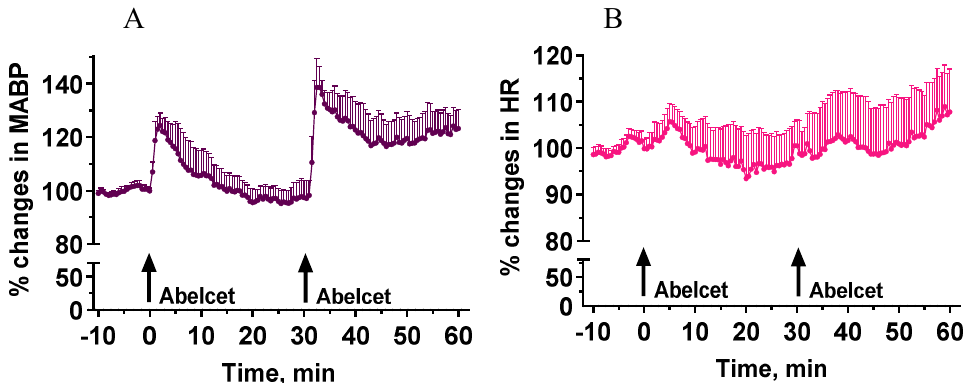
Figure 1. Effects of two sequential treatments with Abelcet (30 mg/kg, i.v.) on MABP and HR in anesthetized NMRI mice (n = 5). The time of i.v. Abelcet injection is indicated by arrows. ( A ): mean arterial blood pressure (MABP); ( B ): heart rate (HR). The two MABP and HR curves (for 30 min from Abelcet administration) were compared using two-way ANOVA for repeated measurements followed by Dunnett’s multiple comparison tests. MABP and HR changes were similar after the Abelcet administrations.